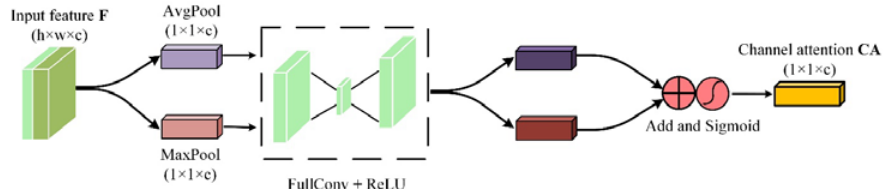
Figure 6. The channel convolutional attention